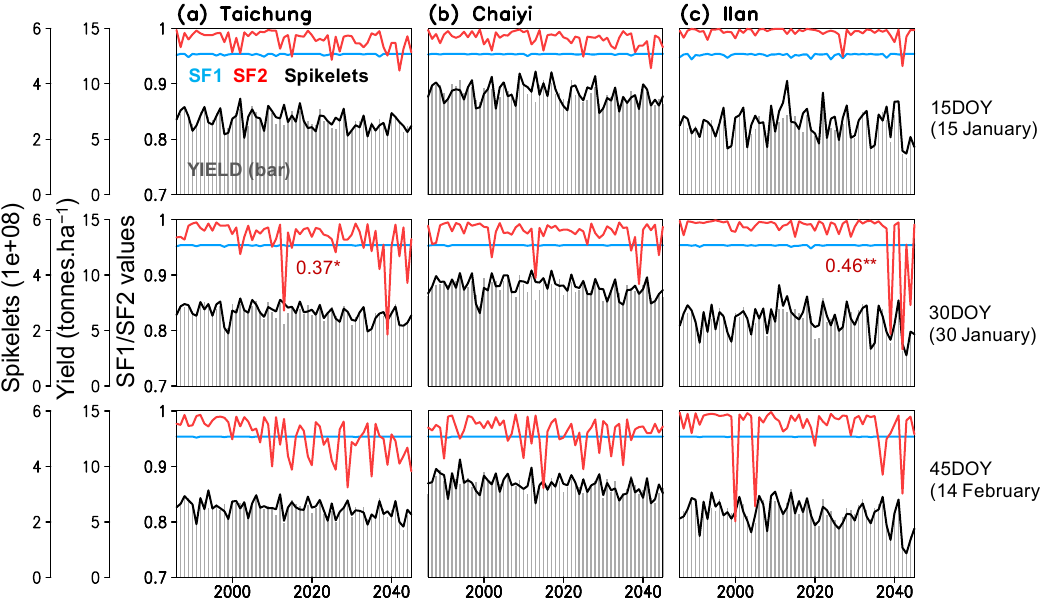
Figure 7. Time series of simulated yield, number of spikelets, spikelet sterility factor because of low temperature (SF1), and spikelet fertility factor because of high temperature (SF2) for three planting dates (15, 30, 45 day of year) constructed for ( a ) Taichung, ( b ) Chaiyi, and ( c ) Ilan; numbers are correlation coefficients of SF2 and yield (*, ** indicate significant of the coefficients exceeding 99% and 99.9% confidence interval).